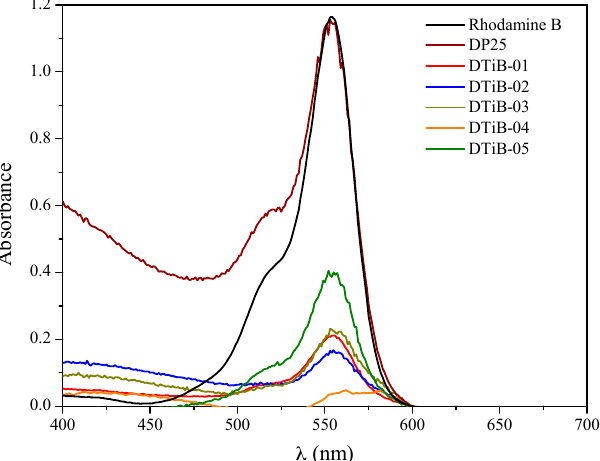
Figure 8. UV-Vis spectra of the final concentration of Rhodamine B after a 20 min adsorption process in the presence of all the photocatalysts.